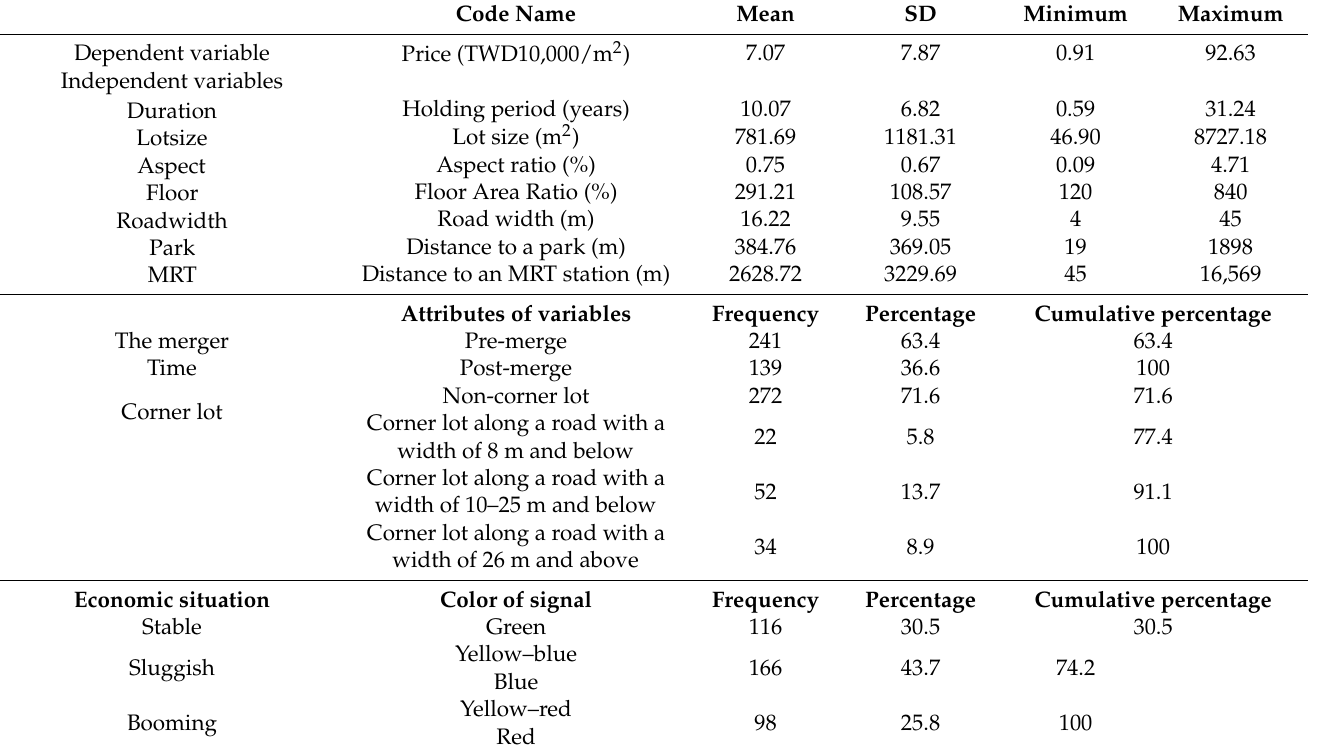
Table 2. Descriptive statistics of the Level 1 independent variables.